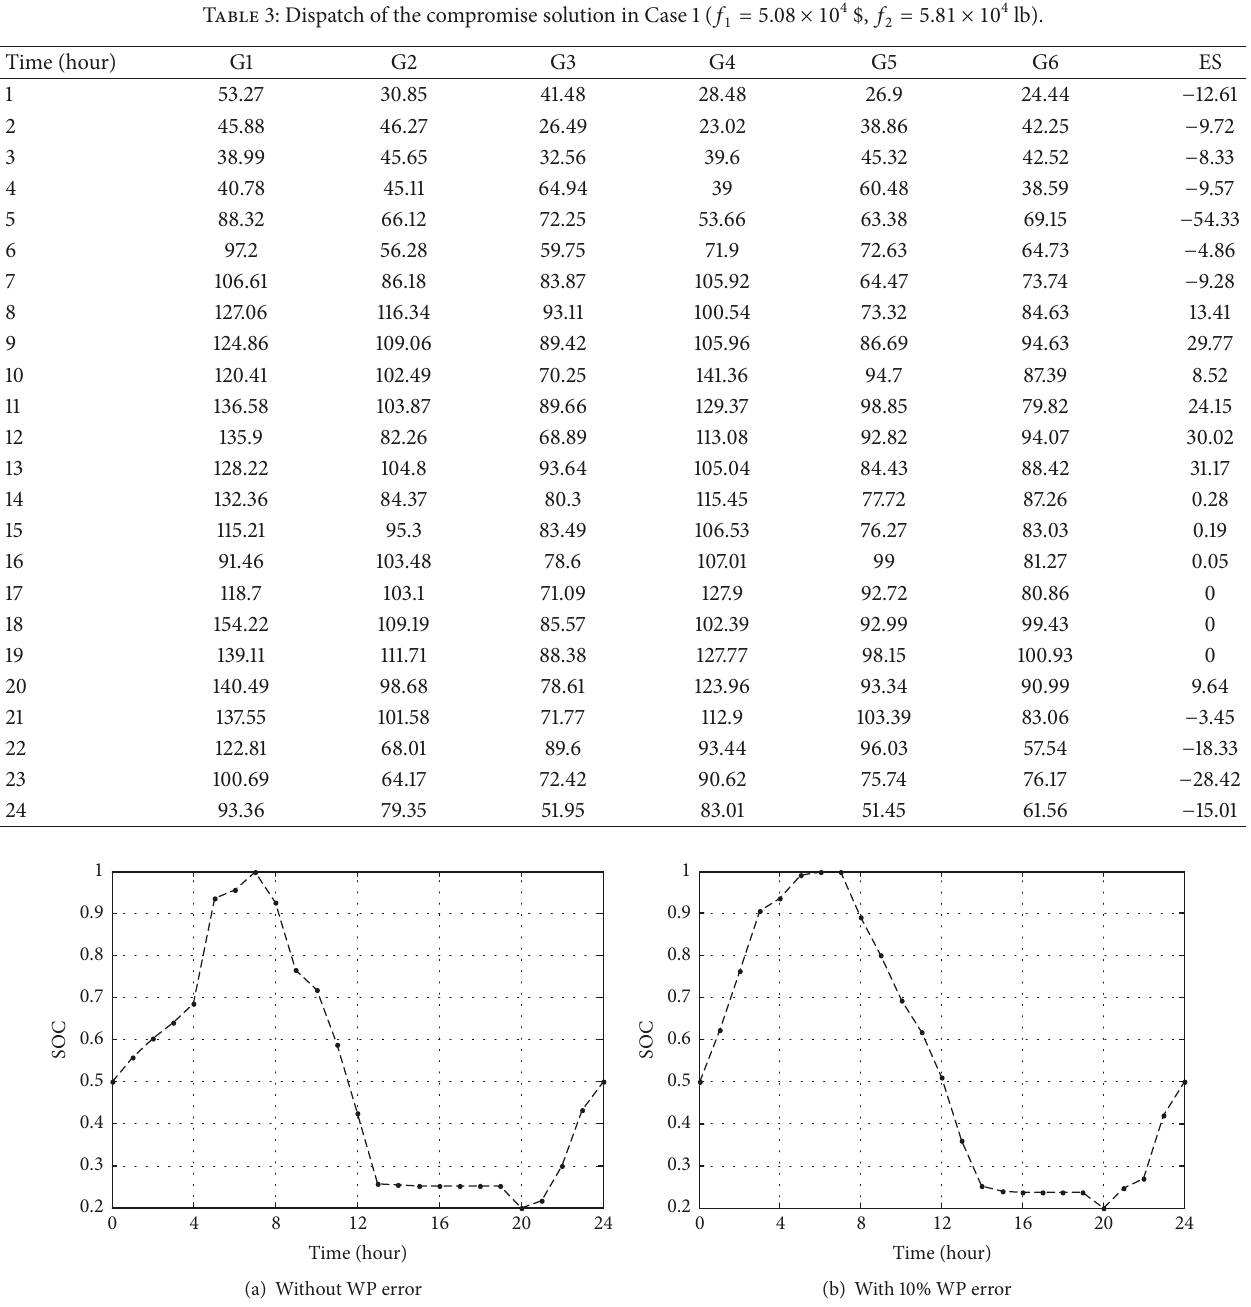
Figure 7: ES SOC at different scenarios in Cases 1 and 2 with 10% WP